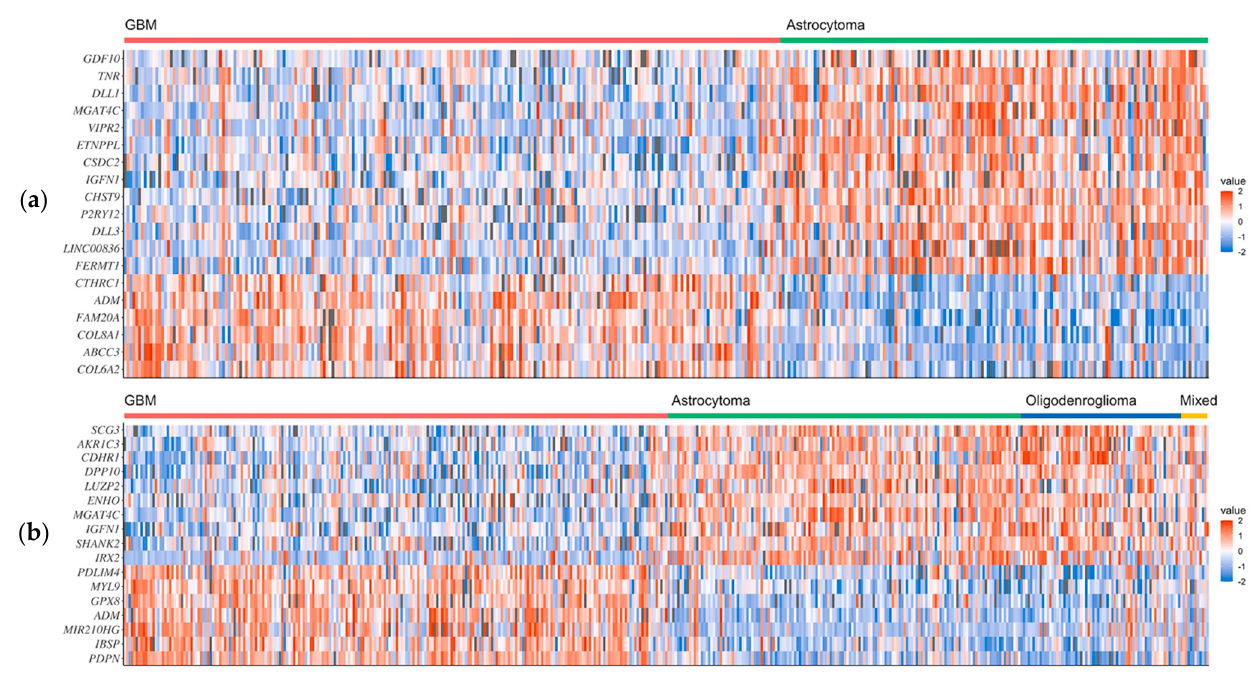
Figure 1. Heatmaps of the selected signature genes of GBM from the ( a ) GBM1 and ( b ) GBM2 datasets.